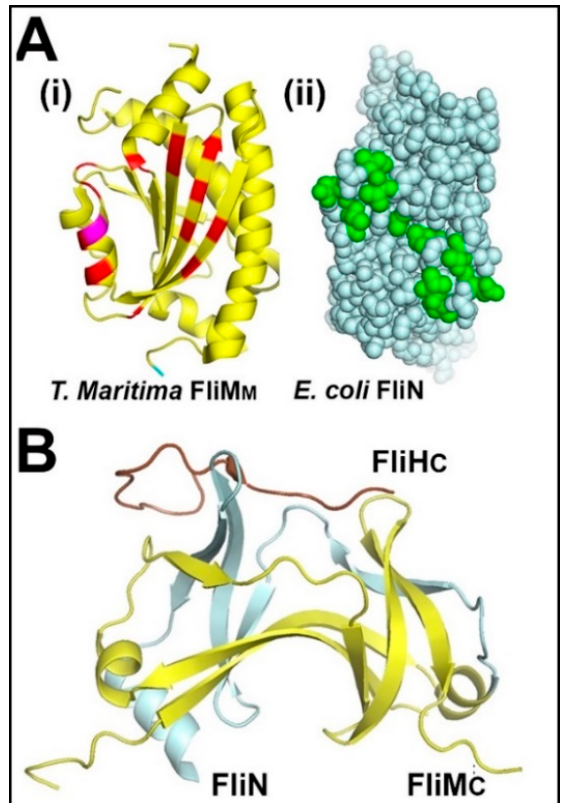
Figure 4. Chemotactic signal processing in the basal C ring. ( A ) Secondary CheY binding sites: ( i ) T. maritima FliM M residues showing NMR chemical shifts (red) in the presence of BeF3-activated CheY. Strongly shifted residue position (magenta) (PDB: 2hp7 (modified from [90])). ( ii ) E. coli FliN homodimer showing residues that impair binding of an activated CheY-FliM N fusion protein. Substitutions at these residue positions result in CCW rotation (PDB: 1yab (modified from [91])). ( B ) Basal C ring architecture: ( i ) Atomic structure of the FliM C (yellow)–FliN (cyan) heterodimer in complex with the FliHc terminal peptide (brown) fused with lysozyme (PDB: 4yxc (modified from [94])) .